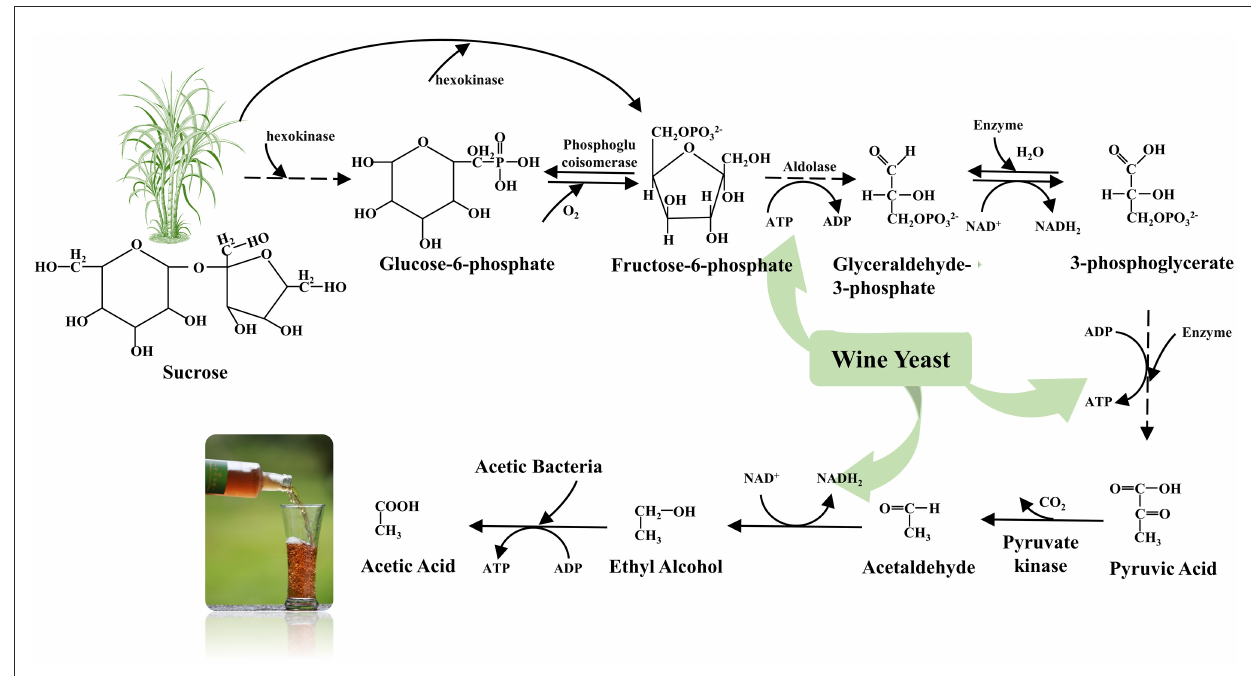
FIGURE2 Conversion of sugarcane raw juice to acetic acid